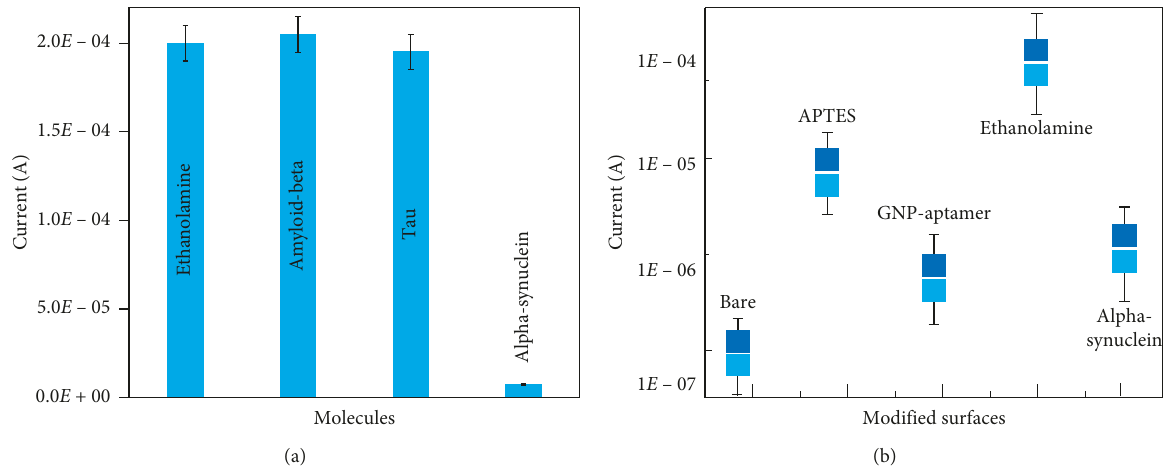
Figure 6: High-performance analysis. (a) Specificity analysis using two closely related proteins, amyloid-beta and tau. The figure shows that the antialpha-synuclein aptamer specifically recognizes alpha-synuclein, while the other aptamers do not show apparent current changes. (b) Reproducibility of different surface modifications on different